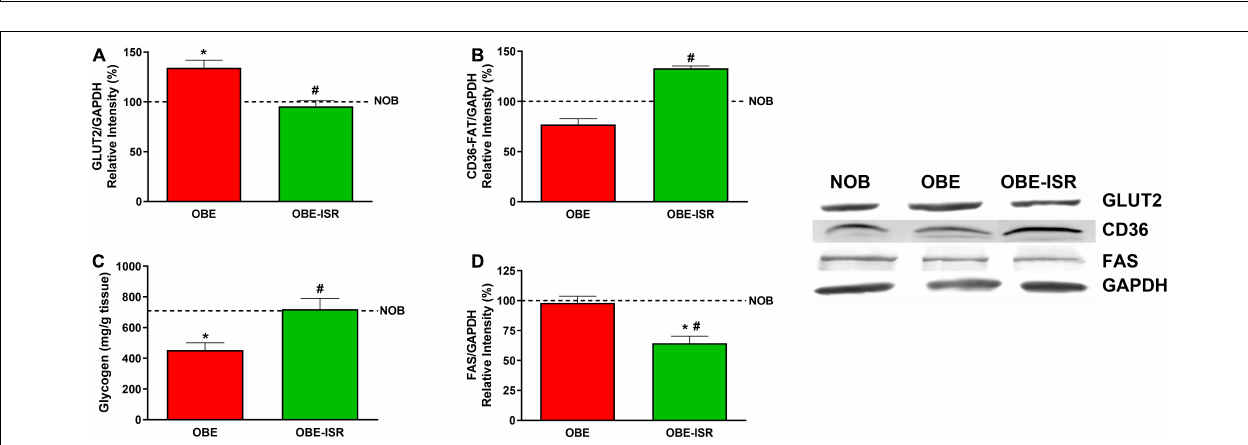
FIGURE 3 | Adipose tissue expression of GLUT4, PKM, uncoupling proteins and lipid synthesis related proteins in the experimental groups. (A) GLUT4. (B) PKM. (C) UCP1. (D) UCP2. (E) FAS. (F) PPAR γ . Rats were fed a normal rodent diet (NOB) or a high-fat diet (HFD) formulated with rapidly (OBE) or with slowly digestible carbohydrates (OBE-ISR). Data expressed as mean ± SEM. *Significant difference with NOB group, p < 0.05. #Significant difference with OBE group, p < 0.05.